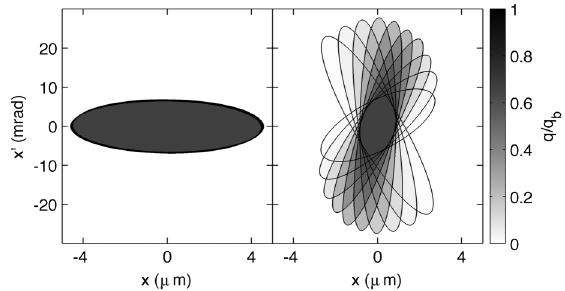
FIG. 1. Ellipses representing bunch slices from PIC simulation C2 (see below) at position z ¼ (cid:1) 0 : 03 mm (left) and z ¼ 1 : 06 mm (right). The gray scale of the ellipse was chosen according to the ratio of the charge in a slice q and total bunch charge q b